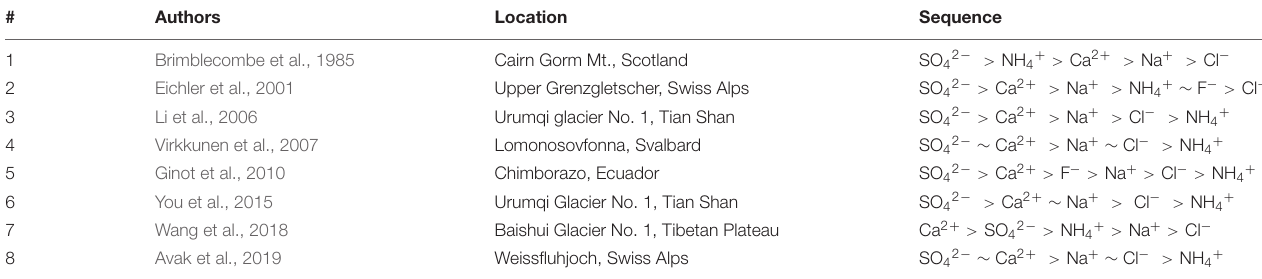
TABLE 4 | Compilation of published elution